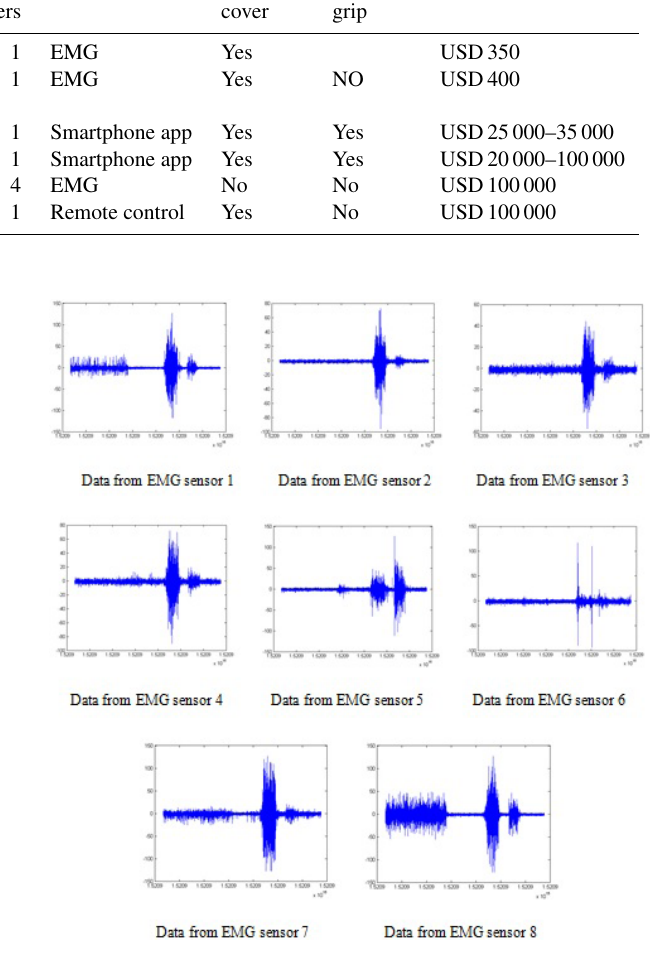
Figure 15. Results of EMG recording of eight electrodes taken from the forearm. Note that the recording patterns are